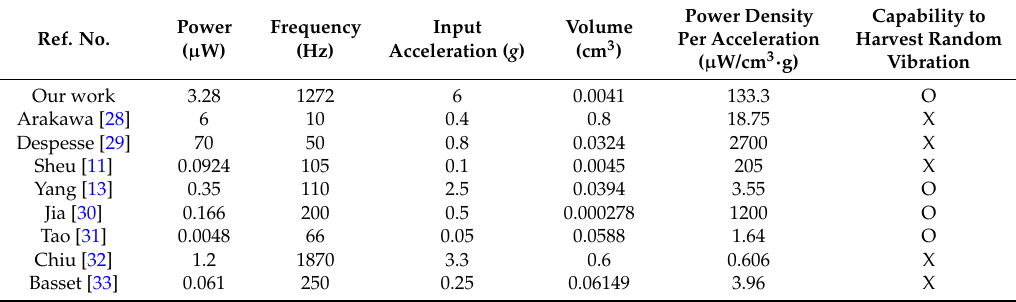
Table 4. Comparison with the other capacitive energy